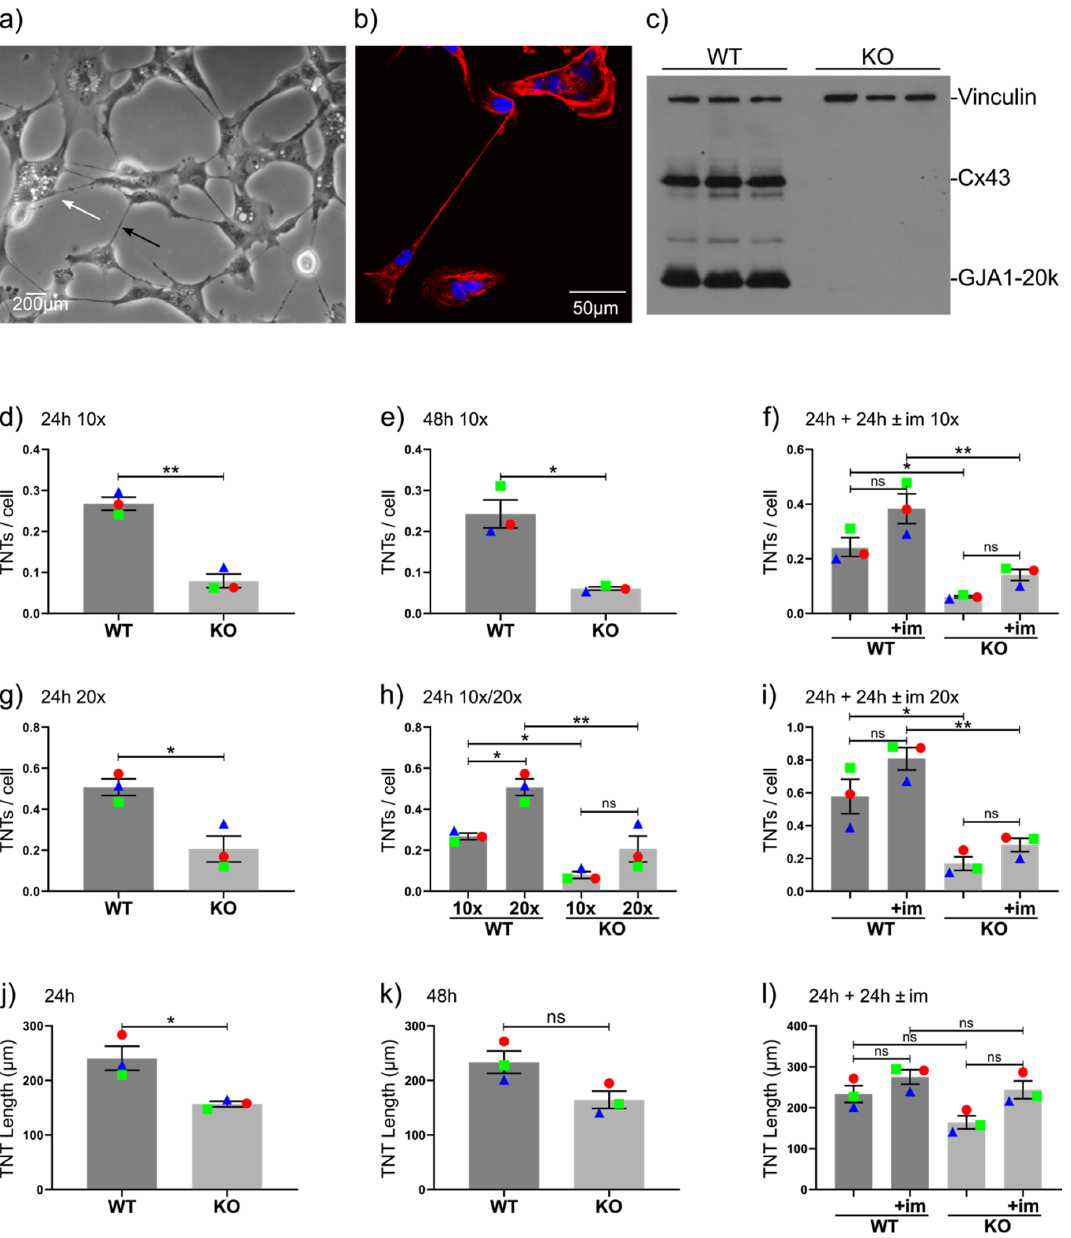
Figure 1. Tunneling nanotubes (TNTs) are regulated by connexin 43 (Cx43) in BT-549 cells. ( a ) Morphological examples of TNTs in BT549 cells (20×). The black arrow denotes a typical “thick” TNT, whereas the white arrow denotes a typical “thin” TNT that is often only visible at higher magnifications. ( b ) Confocal image of BT-549 cells stained with F-actin and the nuclear stain 4 ′ ,6- diamidino-2-phenylindole (DAPI) demonstrating a long, thin, F-actin–positive TNT. ( c ) Western blot with independently isolated samples of three wild type (WT) and three CRISPR-Cas9 Cx43 knockout (KO) BT549 cells showing the presence or absence (respectively) of both Cx43 (43 kDa) and the truncated GJA1-20k form (20 kDa), as well as some other weakly expressed truncated forms of Cx43. The blot was co-incubated with a vinculin antibody (124 kDa) as an internal loading control. ( d and e ) Average numbers of TNTs per cell in WT and Cx43 KO BT549 cells at 10× (counting thick TNTs)